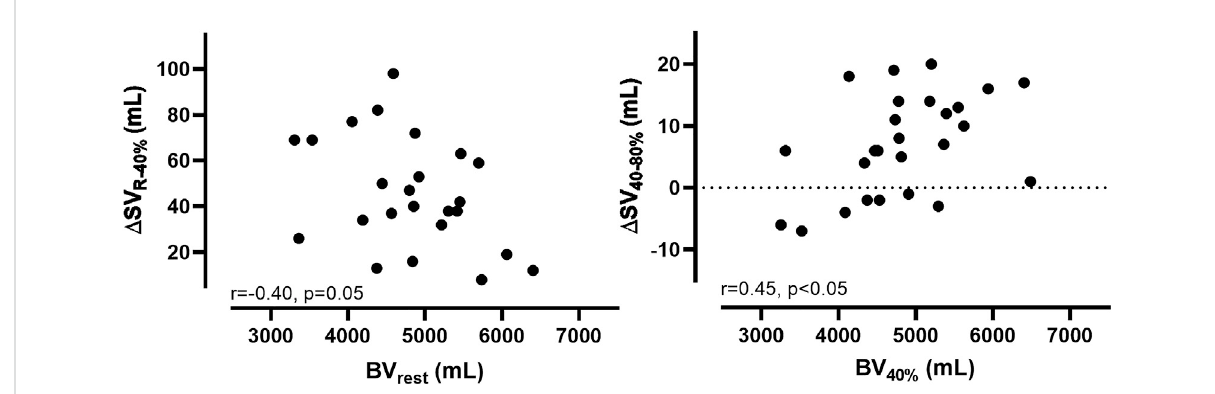
FIGURE 2 Correlations( r ) and levels of signi fi cance ( p )betweenthechanges instroke volume ( Δ SV) and blood volume ( Δ BV) from rest to 40% V _ O 2max and from 40% V _ O 2max to 80% V _ O 2max